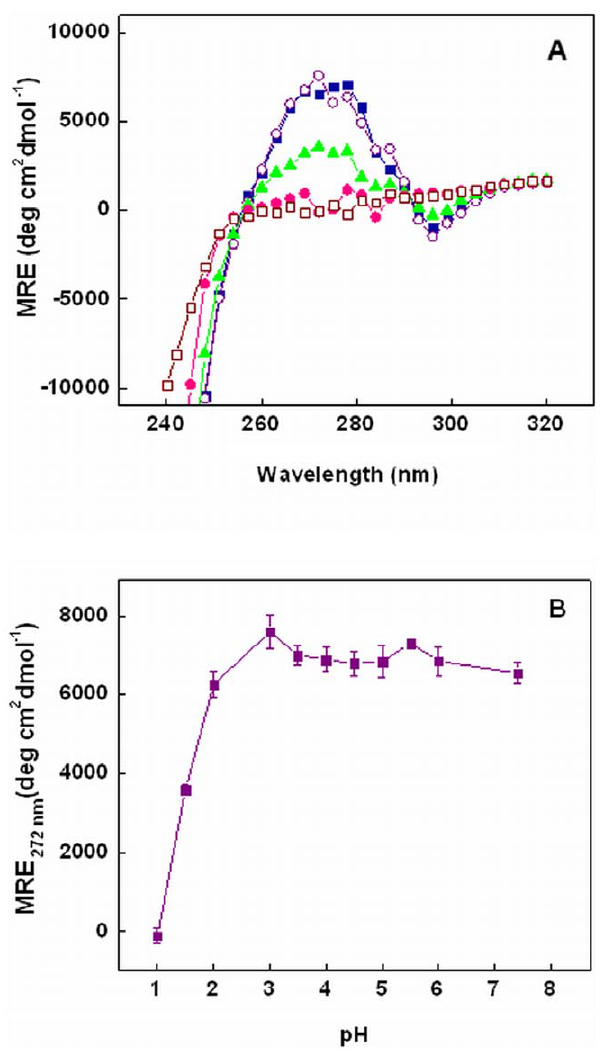
Figure 3. Effect of pH on near-UV CD of chymopapain. (A) Near- N UV CD spectra of chymopapain at pH 7.4 (- & -), pH 3.0 (- # -), pH 1.5 (- m -), pH 1.0 (- -) and in the presence of 6M GuHCl (- % -). (B) pH dependent alterations in mean residual ellipticity (MRE) at 272 nm